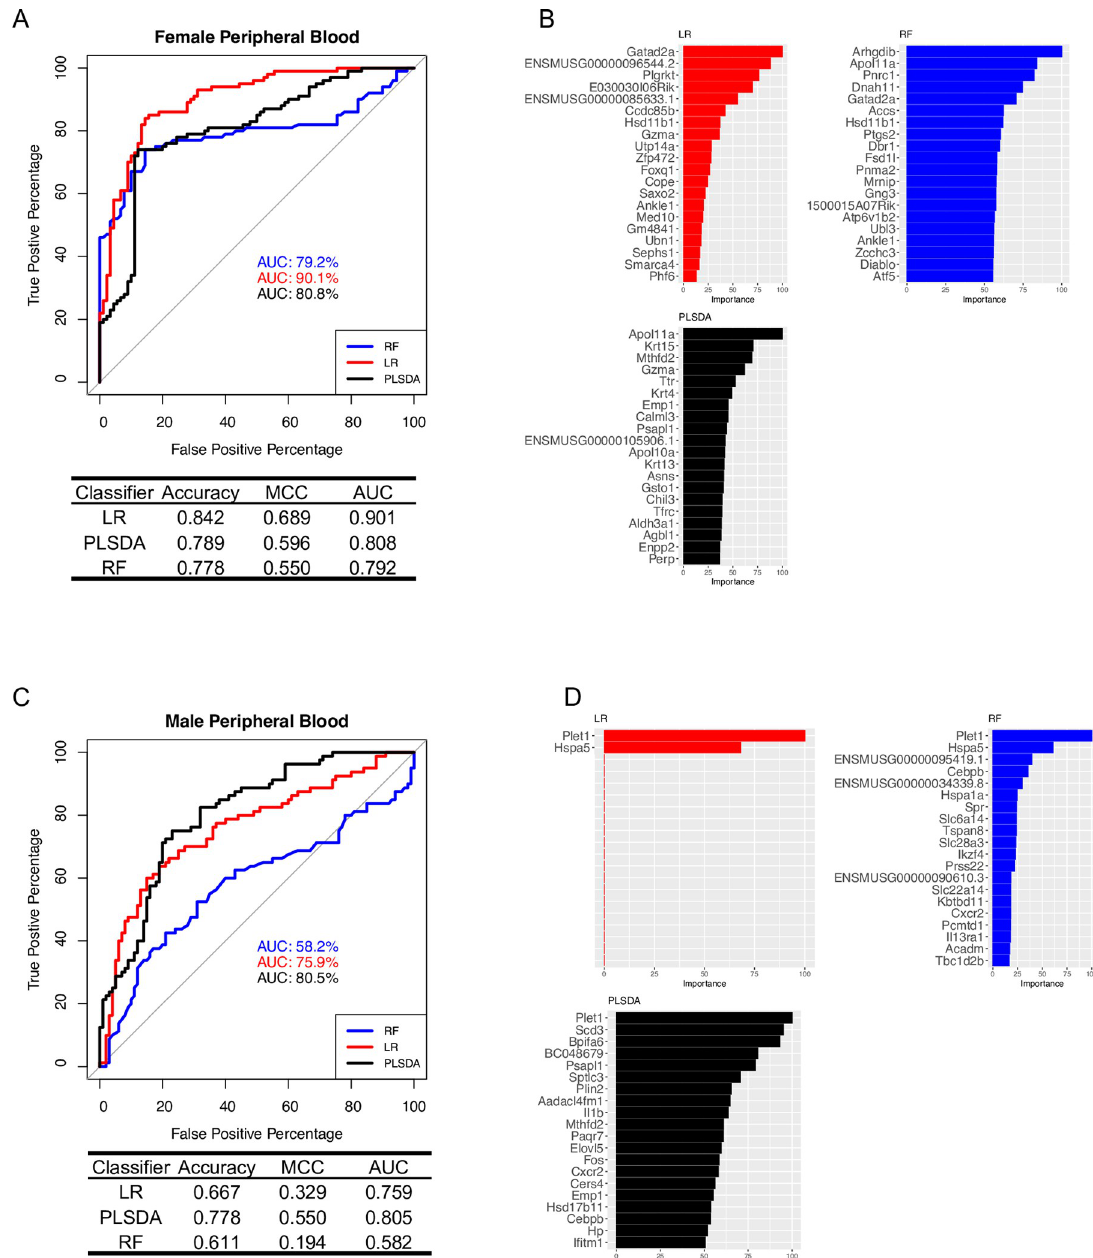
Fig 5. Classification Performance Using Blood Gene Expression. Machine learning classifiers were trained using peripheral whole blood gene expression data to predict alcohol dependence status. Receiver Operating Characteristic (ROC) curves are shown for the classification techniques indicated by the line type in the legend for (A) female and (C) male C57BL/6J mice. The ROC curve shows the relationship between the True Positive Rate (y-axis) and the False Positive Rate (x-axis) resulting from a set of binary classification tests based on each possible decision threshold value. The area under the curve (AUC) for each classifier is displayed in the graph in a corresponding color. The diagonal represents chance levels which corresponds to an AUC of 0.50. A table below the ROC curve shows different performance metrics of the classifiers. The top 20 important genes for the classification task are shown for (B) females and (D) males for the separate models. RF = Random Forest, LR = Logistic Regression, PLSDA = Partial Least Squares Discriminant Analysis, MCC = Matthews Correlation